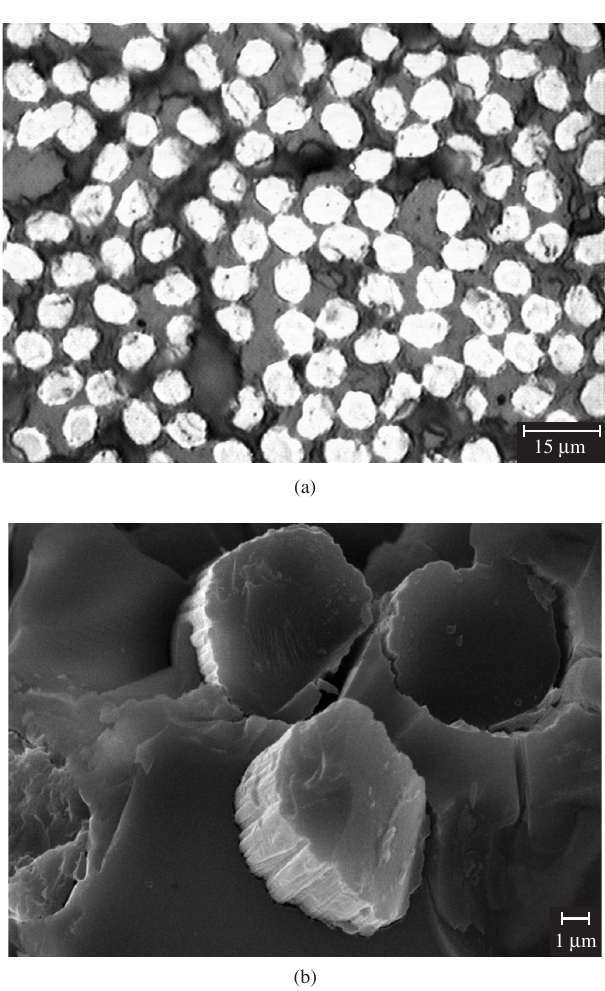
Figure 5. SEM micrograph of the green body prepared from PBS-derived MTES with an atomic ratio of B/Si = 0.2.